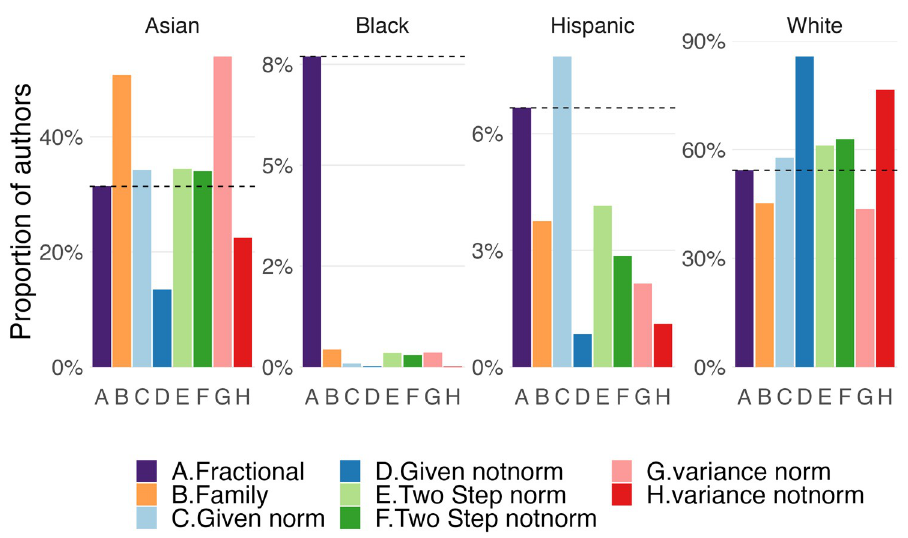
Fig 4. Resulting distribution on different models with 90% threshold. Fractional counting on family names for comparison.